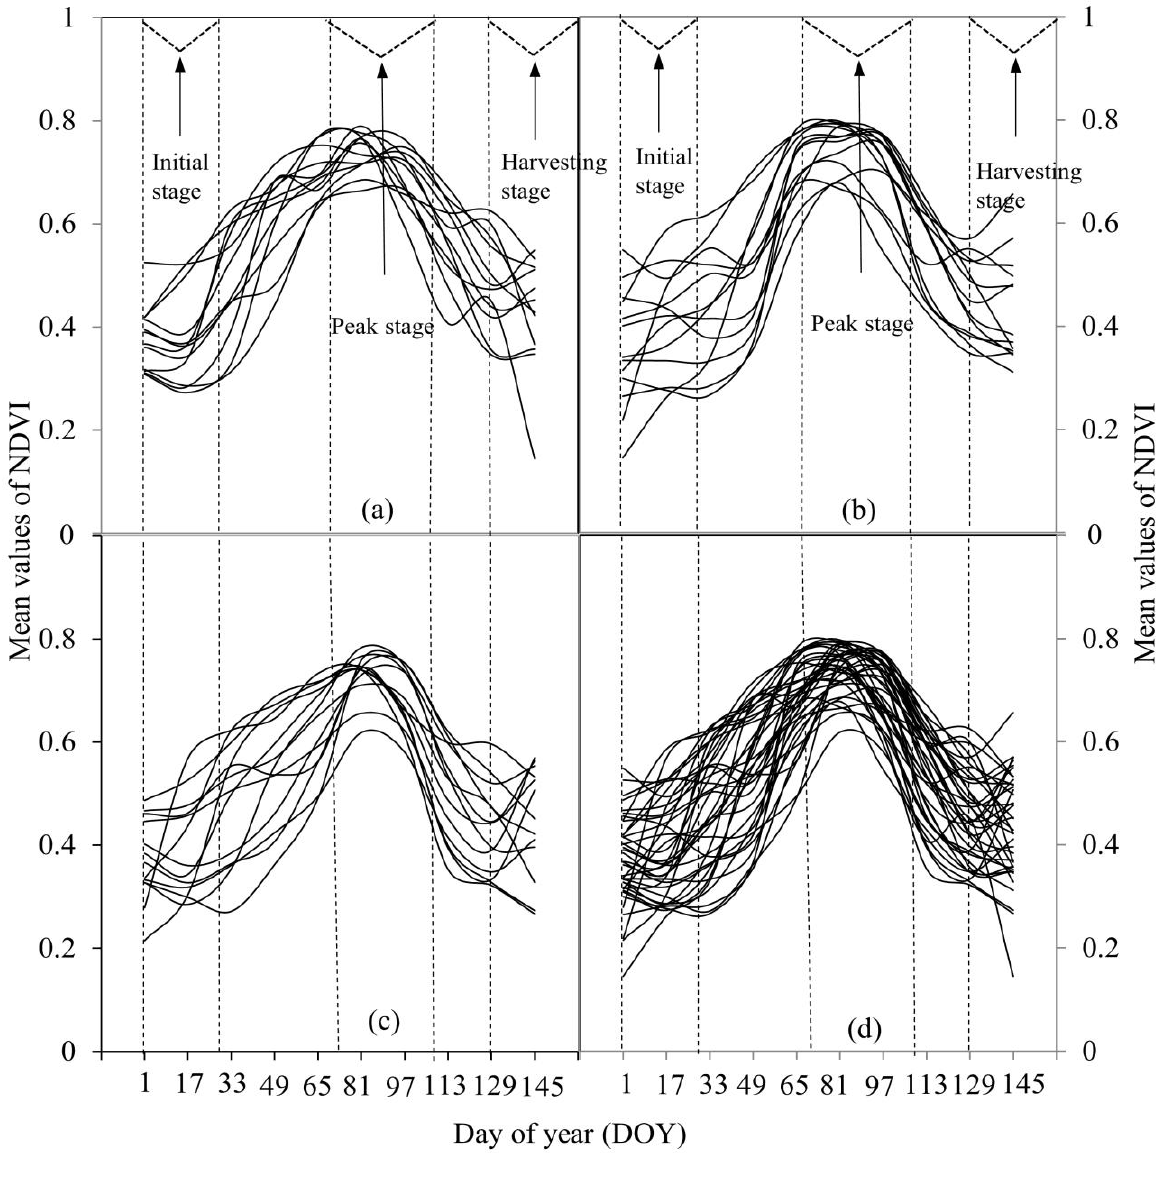
Figure 3. Temporal dynamics of NDVI-based boro rice signatures over the entire growing season using data for ( a ) 2007; ( b ) 2008; ( c ) 2009; and ( d ) 2007–2009.